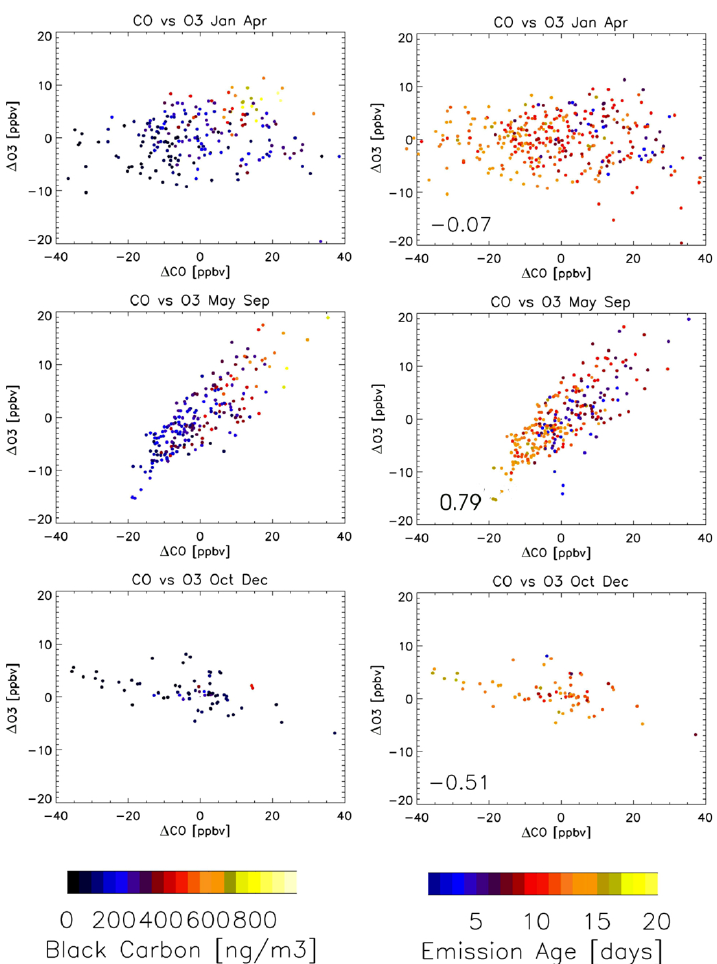
Fig. 8. Observed CO and O 3 anomalies ( 1 CO and 1 O 3 ) for January–April (top), May–September (middle) and October–December (bot- tom). Left column shows data tagged with BC concentrations observed at ICO-OV, while right column shows data tagged with emission age of CO ant from FLEXPART. Linear correlation coefficients between 1 CO and 1 O 3 ( R ) are reported for each plot in the left column. Data are averaged over a 24-h time